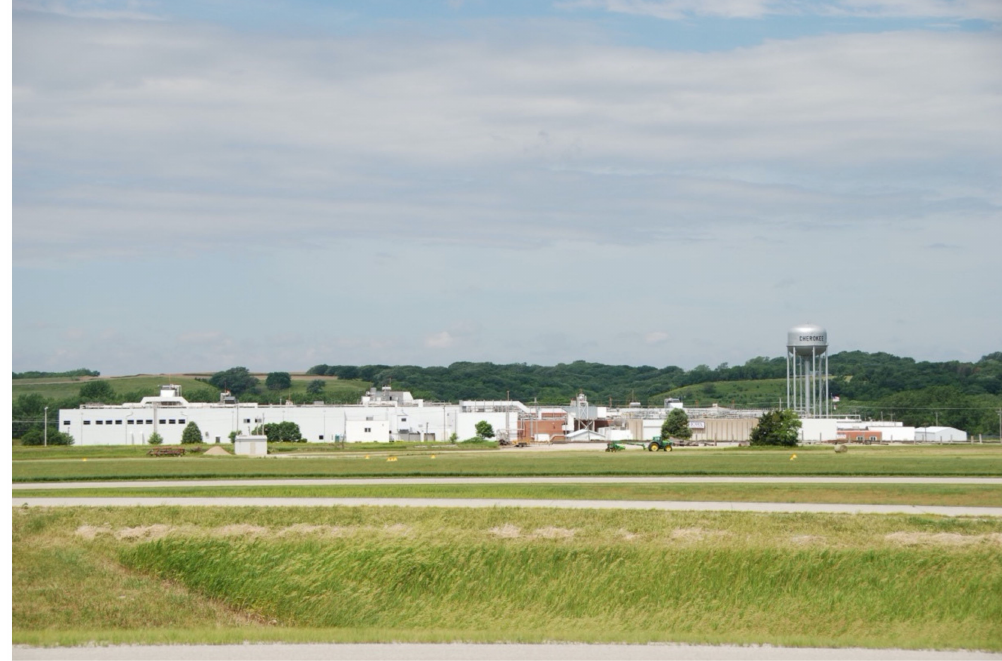
Figure 7. From transect across Northwest Iowa: Stage 3–Treading Water. Meat processing plant in